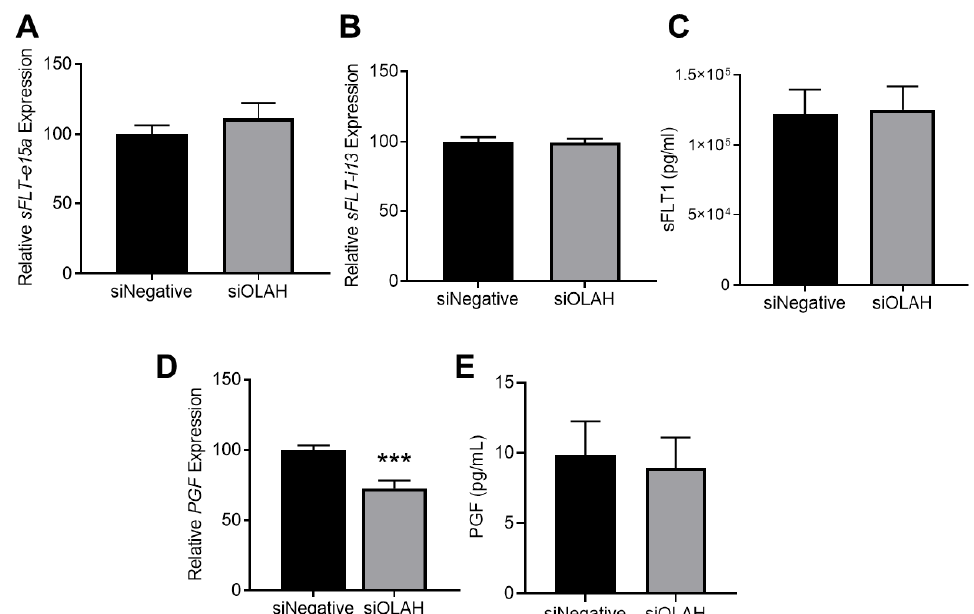
Figure 6. Effect of silencing OLAH on expression and secretion of anti-angiogenic sFLT1 and angio- genic PGF from cytotrophoblast cells under hypoxia (1% O 2 ). Gene expression assessed via qPCR and protein secretion by ELISA. Silencing OLAH in cytotrophoblast cells did not alter expression of sFLT1 isoforms sFLT-e15a ( A ), sFLT-i13 ( B ), nor sFLT1 secretion ( C ) under hypoxia. Silencing OLAH significantly reduced the expression of PGF ( D ), but did not alter PGF secretion ( E ) under hypoxia. Data presented as mean ± SEM. n = 3 – 4, each sample from a different patient. *** p < 0.001. We also assessed the effects of silencing cytotrophoblast OLAH on sFLT1 and PGF levels in normoxic conditions to evaluate a potential role for OLAH in normal placental function. Here, we found that silencing OLAH did not alter sFLT-e15a expression (Supple- mentary Figure S3A), but significantly increased sFLT-i13 expression ( p = 0.0252; Supple- mentary Figure S3B), though sFLT1 secretion was not altered (Supplementary Figure S3C). Silencing OLAH under normoxic conditions did not alter cytotrophoblast PGF ex- pression (Supplementary Figure S3D) or secretion (Supplementary Figure S3E).